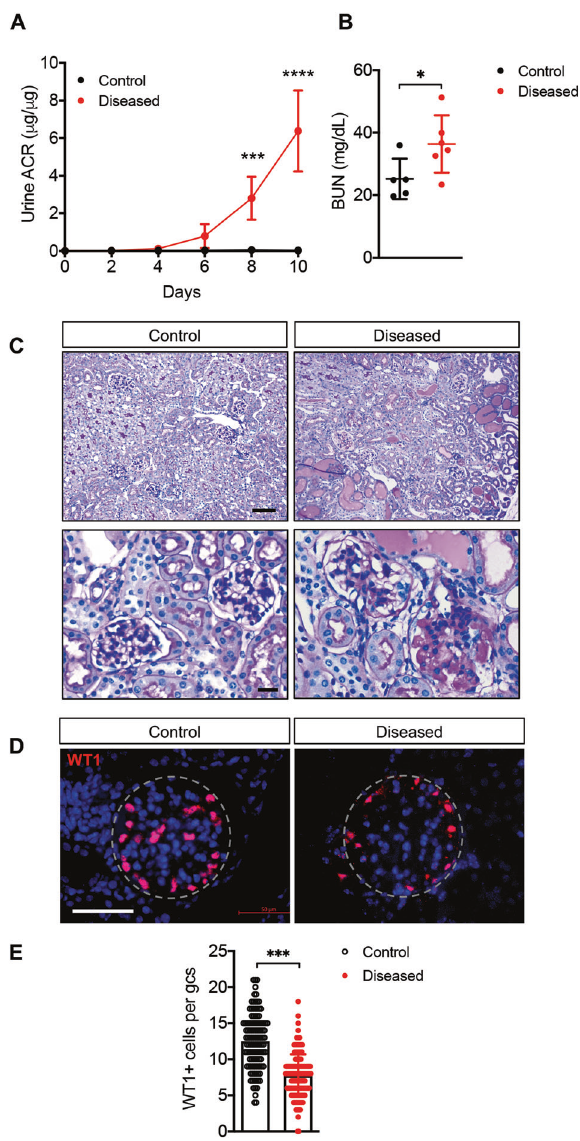
Fig. 1 DT-induced podocyte depletion in Flk1-EYFP mice. A Urinary albumin-to-creatinine (UACR) ratio in samples collected after DT injection ( n = 5 – 6 mice per group). *** p < 0.001 and **** p < 0.0001 when compared between groups by two-way ANOVA with Bonferroni ’ s correction. B Blood urea nitrogen (BUN) levels at 10 days after DT injection ( n = 5 control, n = 6 diseased). * P < 0.05 between groups by unpaired two-tailed t -test with Welch ’ s correc- tion. C Representative images of periodic acid – Schiff (PAS)-stained kidneys in low (top panels) and high (bottom panels) magni fi ca- tions. Scale bars, 100 μ m (top) and 20 μ m (bottom). D Representative images of WT1 immunostaining of kidney sections. Kidney sections were counterstained with Hoechst ( n = 3 mice per group; glomeruli are outlined with dotted lines). Scale bar, 50 μ m. E Quanti fi cation of WT1-positive cell per glomerular cross-section (gcs) ( n = 3 mice per group with at least 60 glomeruli counted per mouse). *** p < 0.001 between groups by unpaired two-tailed t -test with Welch ’ s